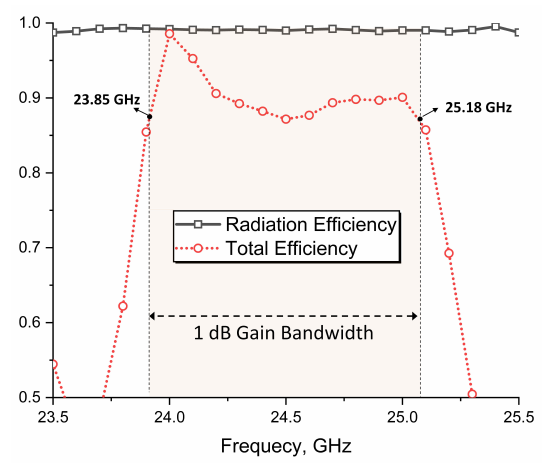
FIGURE 3. VSWR and realized gain characteristics of the